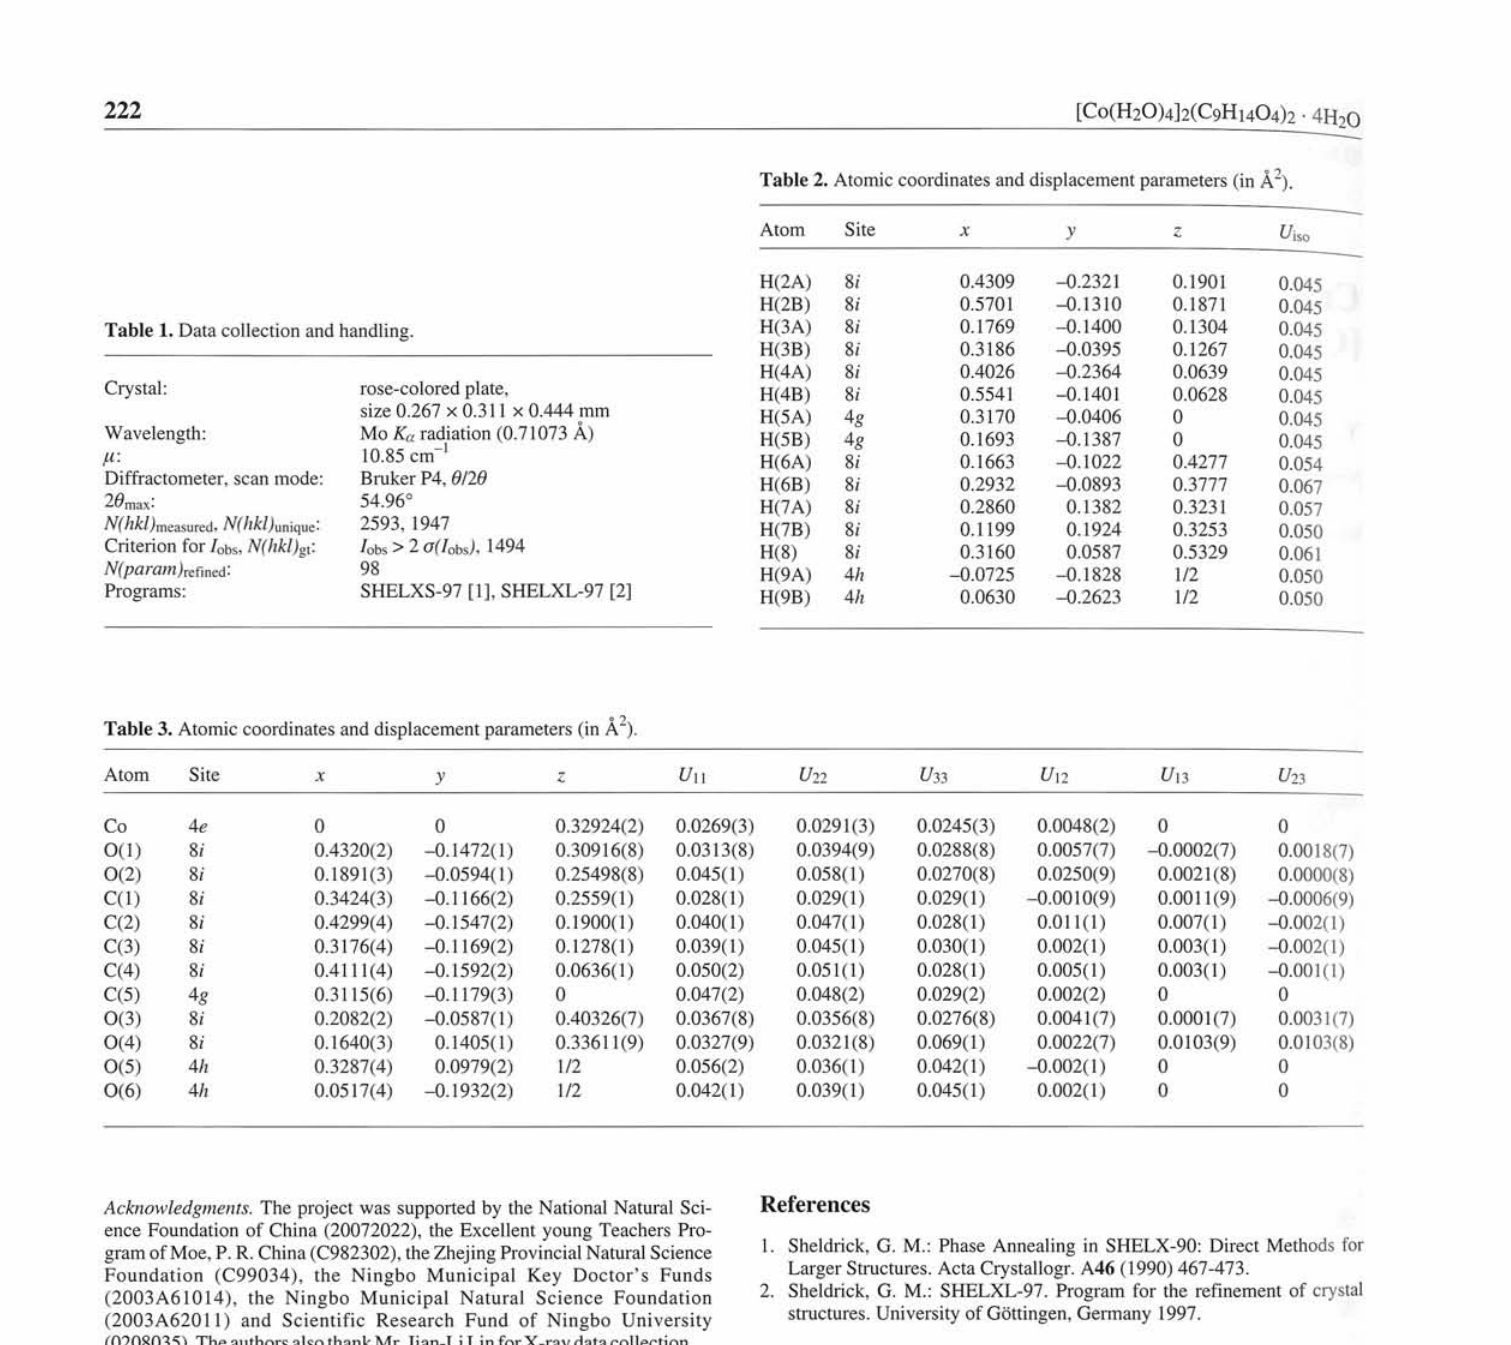
Table 1. Data collection and handling.